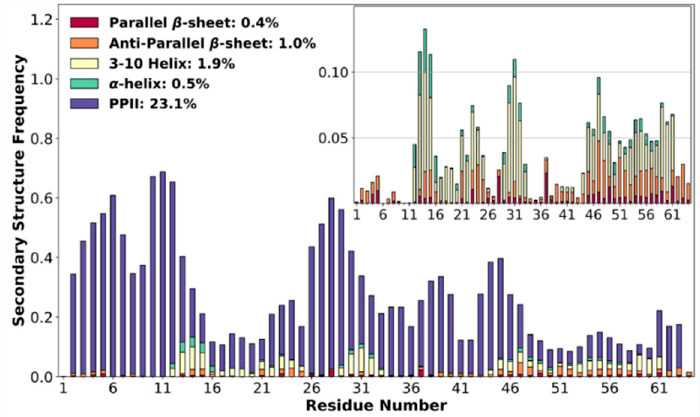
Figure 3. Normalized frequencies of individual residues in various types of secondary structures according to the molecular dynamics (MD) simulations. The inset zooms into the low populations of helices and β -sheets.